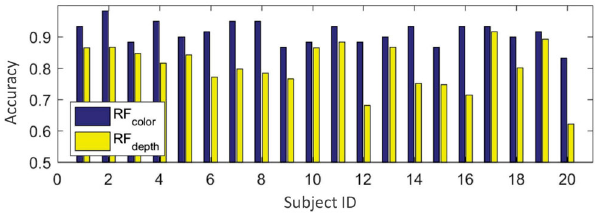
Fig. 14 Phrase recognition accuracies for each subject in the color videos (RF color ) with a patch size of 15 × 15, and the depth videos (RF depth ) with a patch size of 7 × 7, for the KinectVS dataset.